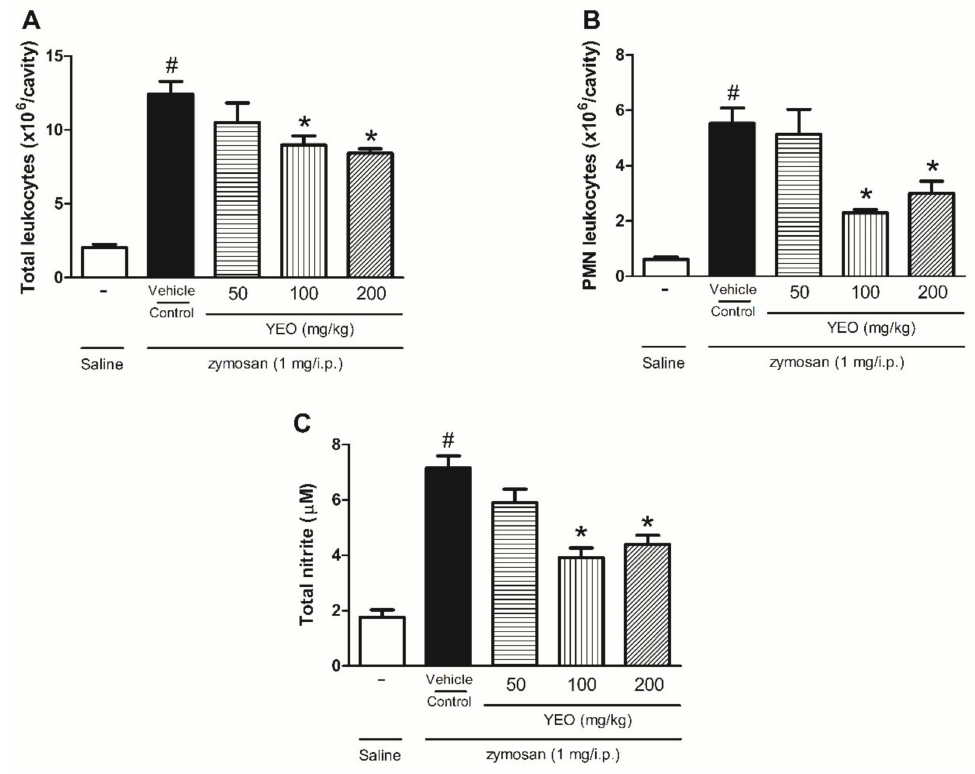
Figure 3. Effect of YEO treatment on migrated leukocyte number and NO production in the peritoneal cavity of Swiss mice 6 h after the zymosan injection (1mg/cavity/i.p). The effect of YEO treatments on leukocyte counts 6 h after the zymosan injection in Swiss mice ( A ), on PMN number ( B ), and on NO production ( C ). # p < 0.05 compared to saline (vehicle). * p < 0.05 compared to the control